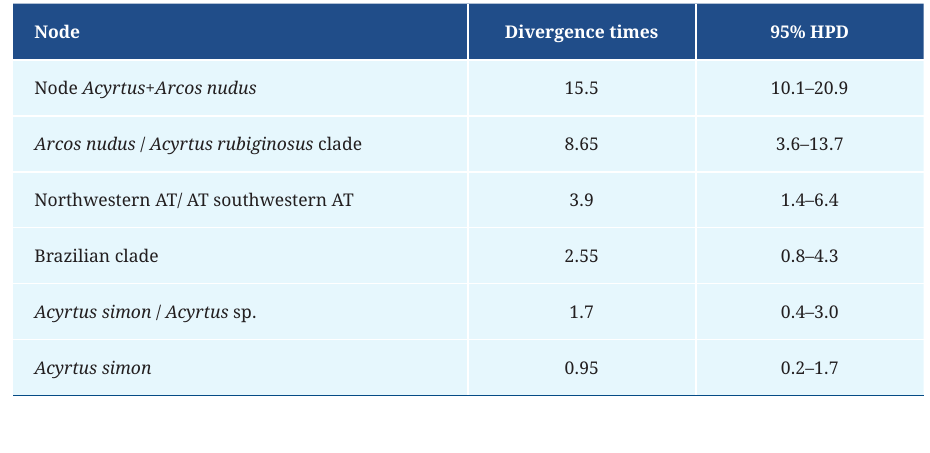
TABLE 4 | Divergence times (Mya) among Acyrtus species and Arcos nudus , and the 95% highest posterior density.